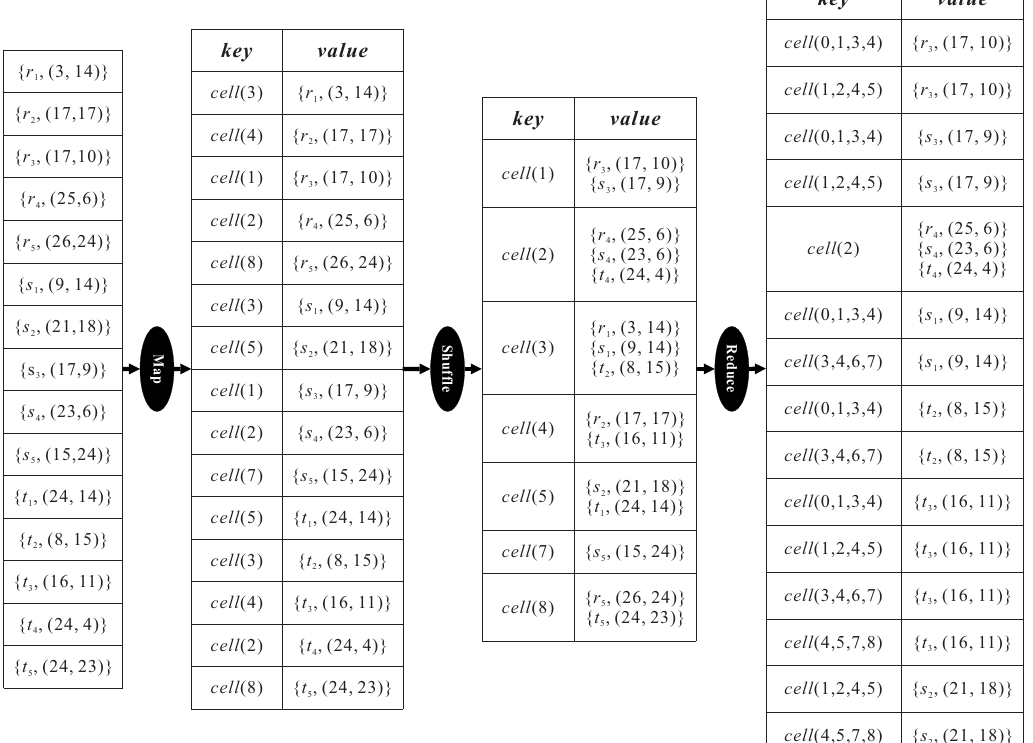
Figure 4. Illustration of the Inner HNO set determining